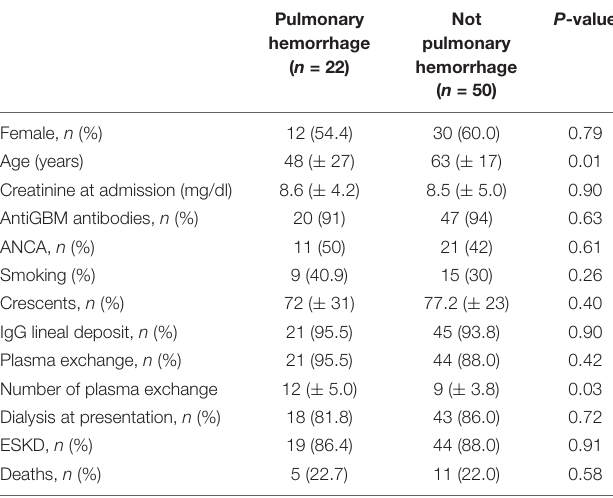
TABLE 2 | Clinical and pathologic characteristics of patients with and without pulmonary